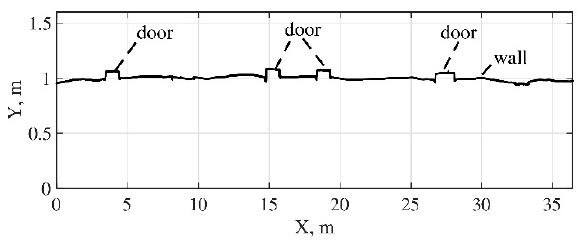
Figure 7. Data recorded during the movement of the vehicle.